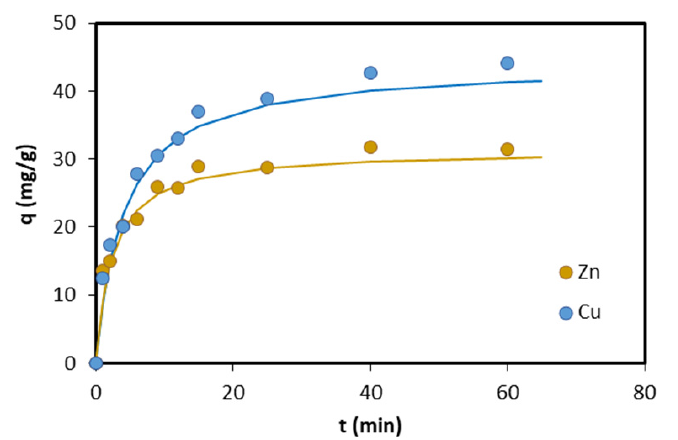
Figure 5. Sorption of Zn and Cu onto the synthesized material (“synt” sample) as a function of time. Symbols represent experimental data and fitting lines were plotted using the pseudo-second order kinetic model.